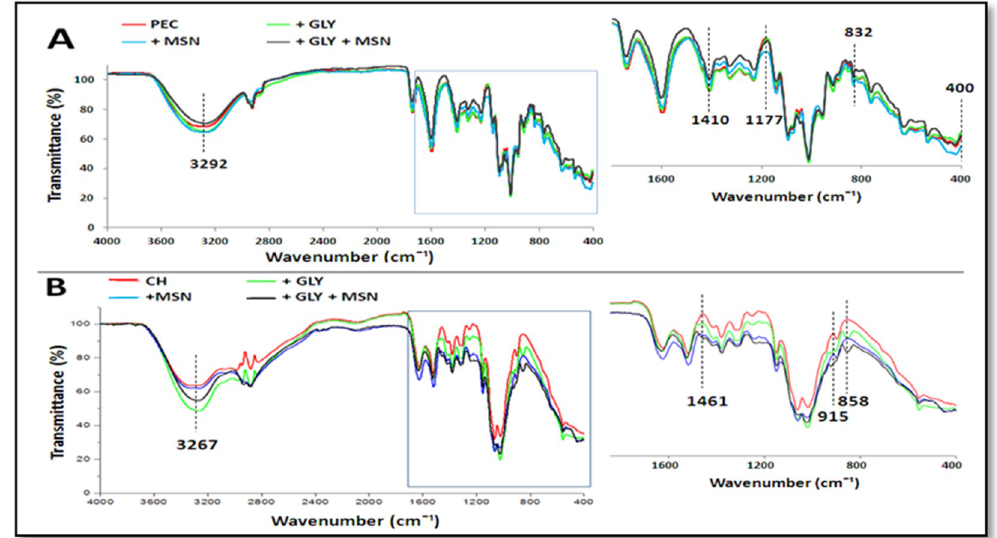
Figure 2. FT-IR spectra of PEC ( A ) and CH ( B ) films prepared in the presence or absence of GLY or MSN.